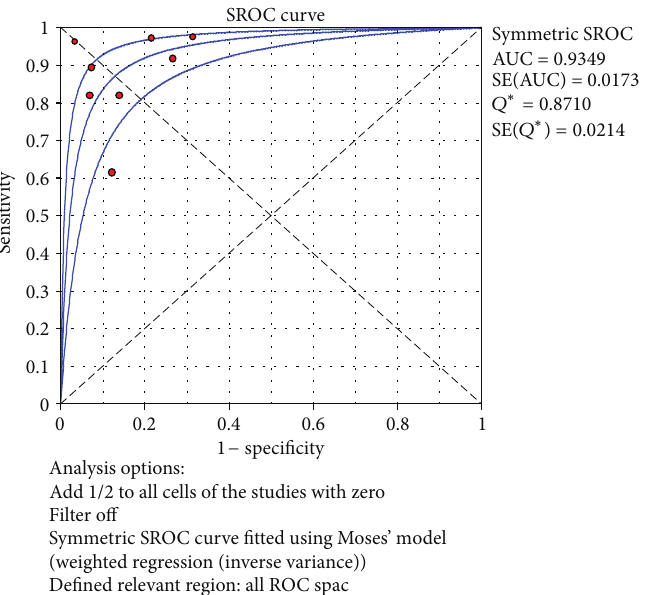
Figure 10: Summary receiver operating characteristic (SROC) curve of the TNF- 𝛼 test for the diagnosis of late-onset neonatal sepsis in the northern hemisphere. Each point represents one study in the SROC